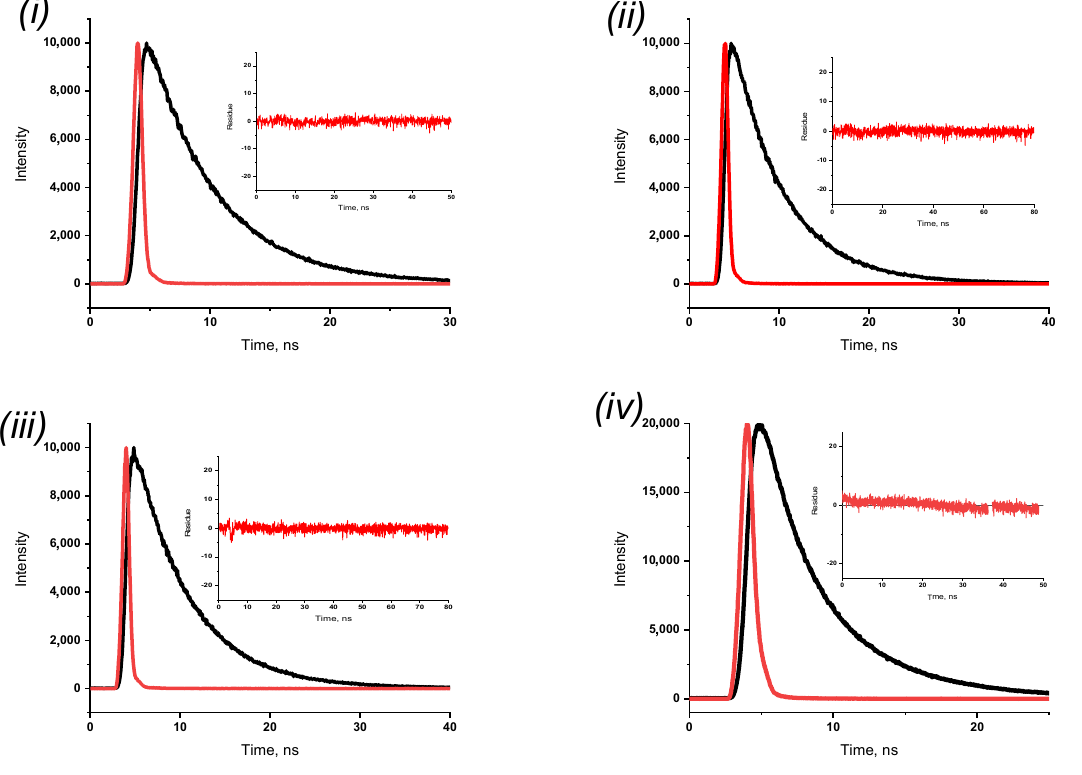
Figure 5. Fluorescence decays with excitation at the absorption maximum of the vibrational satellite for compound 4 ( i ), 5 ( ii ), 6 ( iii ), and 7 ( iv ) solutions in CHCl 3 , sample concentration ~10 µ M (black curve — phthalocyanine decay; red curve—LUDOX decay). Data fitting to monoexponential function using deconvolution method, chi-squared value between 1.00 and 1.15 (note: spectra in acetone and DMF are presented in the Supplementary Materials).